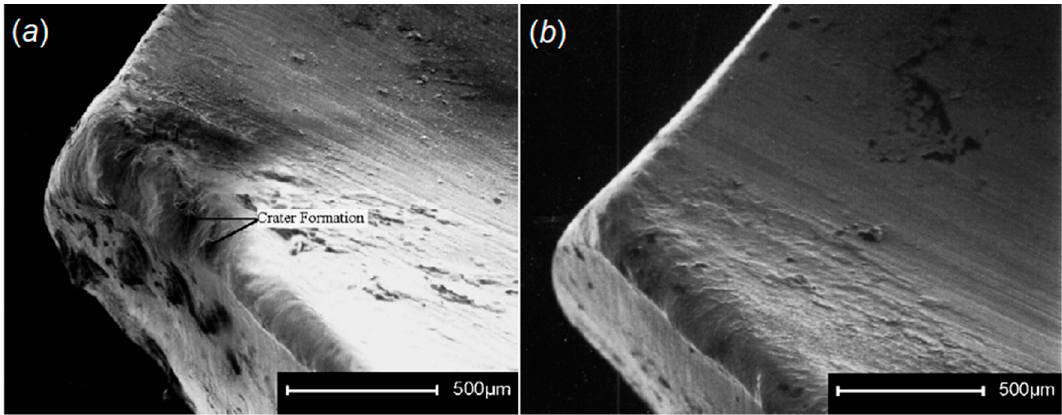
Figure 12. SEM images of drills after drilling of 30 holes: ( a ) nontreated drill and ( b ) cryo-treated with tempering drill [117].